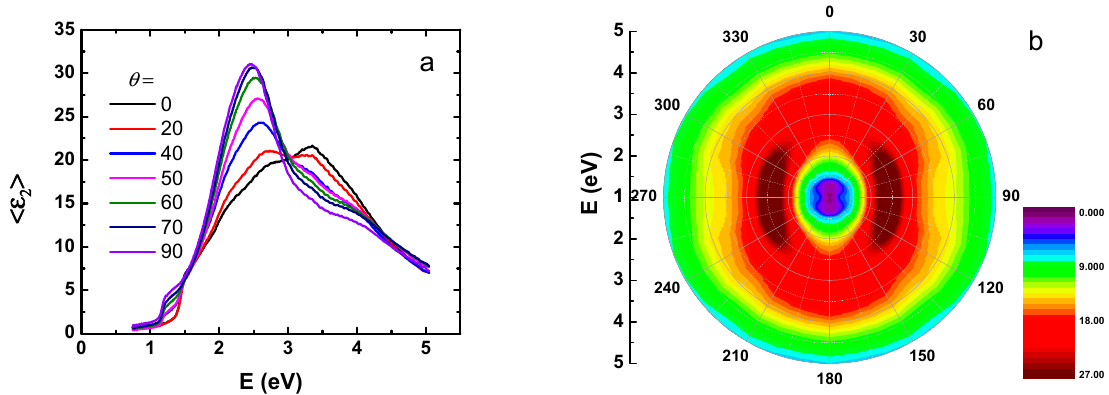
Figure 2. ( a ) Azimuthal angle dependence of the dielectric function from the armchair- to zigzag-directions at AOI = 70 ° . ( b ) Mapping of the full azimuthal angles of the dielectric function of single-crystal SnS 0.52 Se 0.48 .